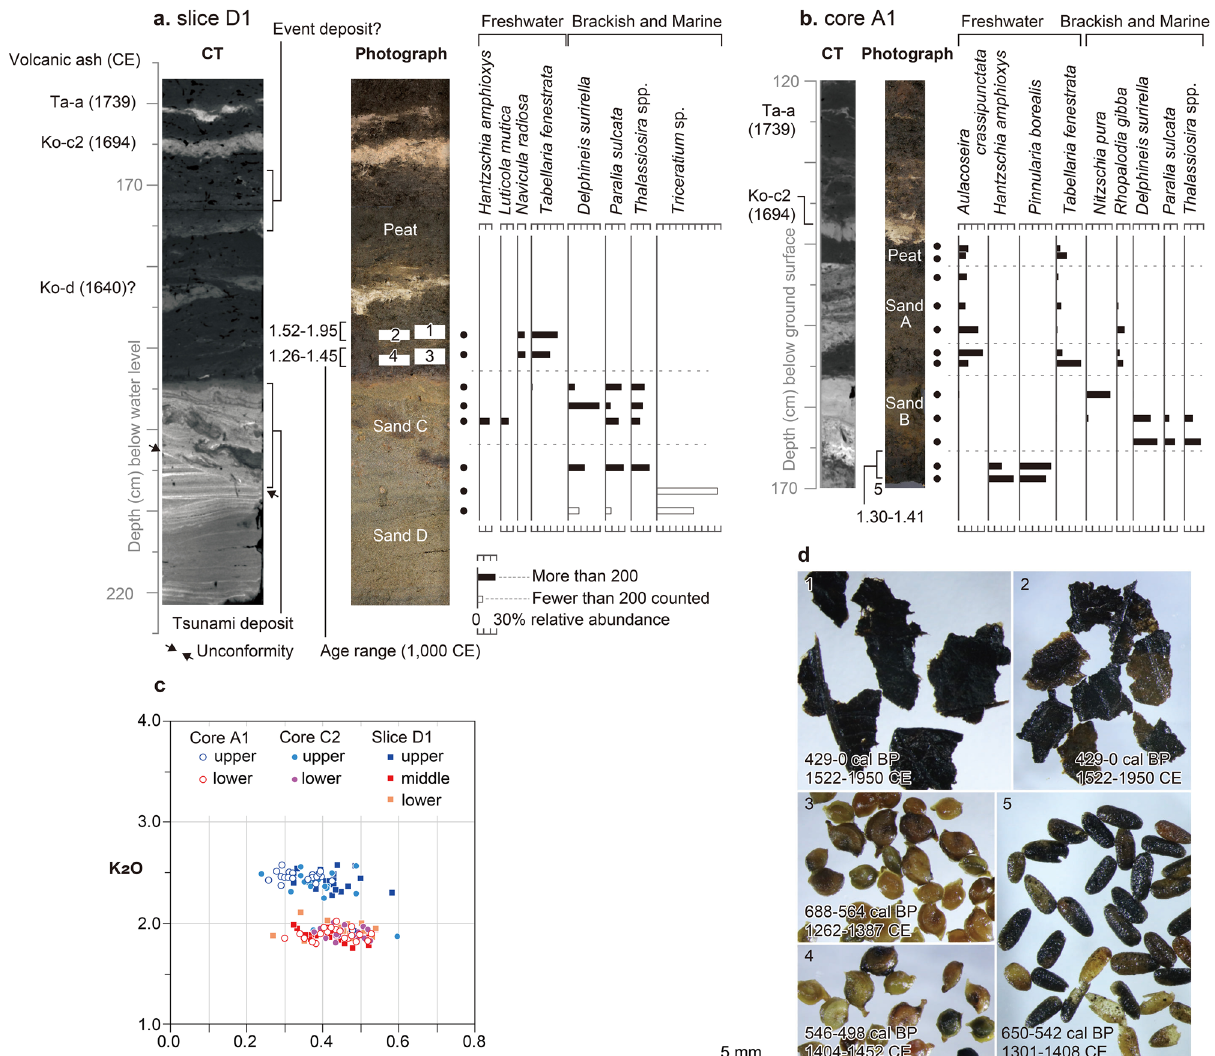
Figure 3. Examples of core samples taken in this study. ( a ) Slice D1. ( b ) Core A1. Shown for each are a CT image with ash layers and structures labeled (left), a photograph with sedimentary units labeled (middle), and changes in compositions of selected diatom taxa (right). White boxes 1–4 in the middle photograph of ( a ) show samples taken for radiocarbon dating. ( c ) Cross plots of K 2 O and TiO 2 of glass shards from ash layers in selected cores. ( d ) Plant macrofossils from peat in slice D1 and core